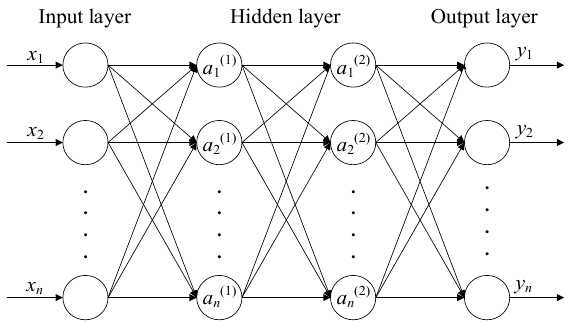
Figure 2. Model of the backpropagation (BP) neural network.